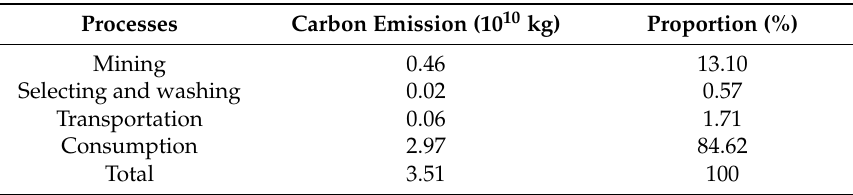
Table 6. Structure of carbon emissions in different processes.